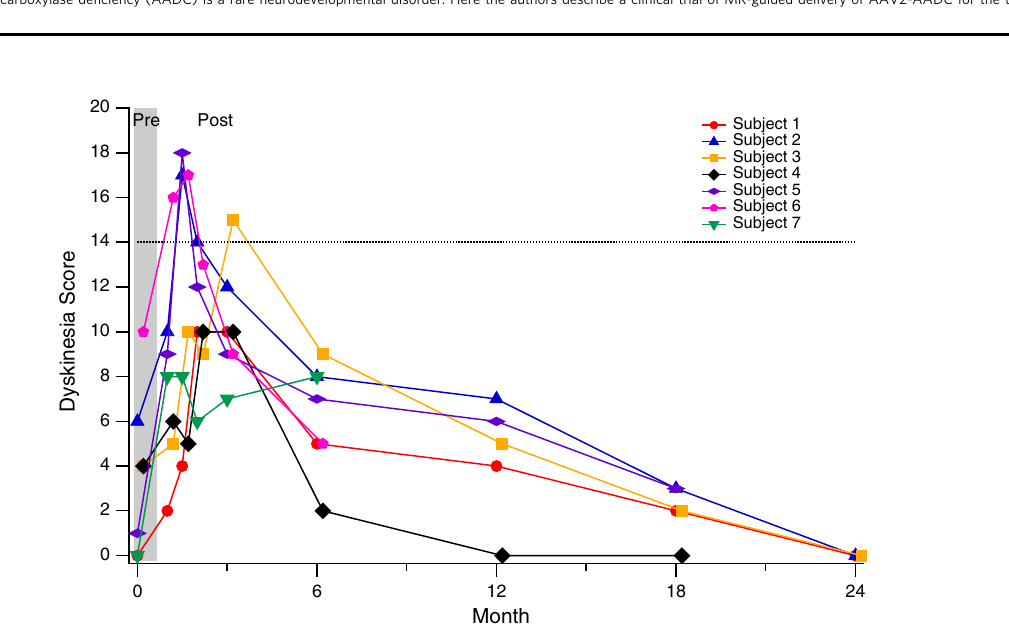
Fig. 5 Time course of dyskinesia after gene transfer. Dyskinesia score, adapted from the Abnormal Involuntary Movement Scale (AIMS). Involuntary movements in each of 7 body regions were scored from 0 (none) to 4 (severe), for a maximum possible score of 28. A total score of 14 (dotted line) may correspond with either mild generalized dyskinesia, or moderate-severe involuntary movements in a more focal distribution. Dyskinesia peaked in severity between 1 and 3 months after surgery, and gradually improved thereafter. At Month 24, dyskinesia had resolved completely in all 3 subjects in Cohort